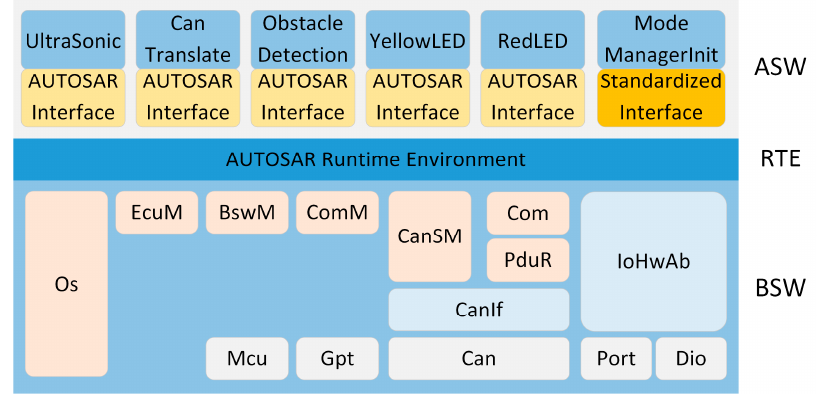
Figure 5. Layered collision warning system architecture.